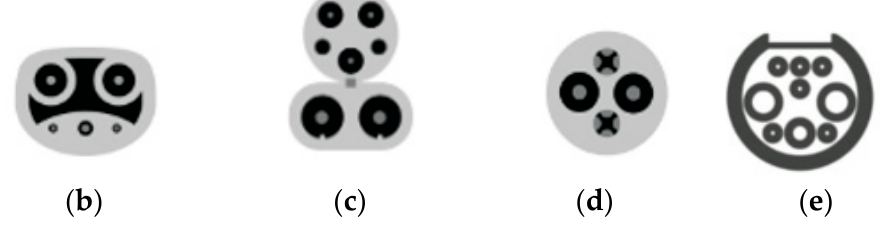
Figure 5. EV charger connecter types ( a ) J1772, ( b ) Tesla, ( c ) CCS, ( d ) CHAdeMO, ( e ) GB/T [17,23].